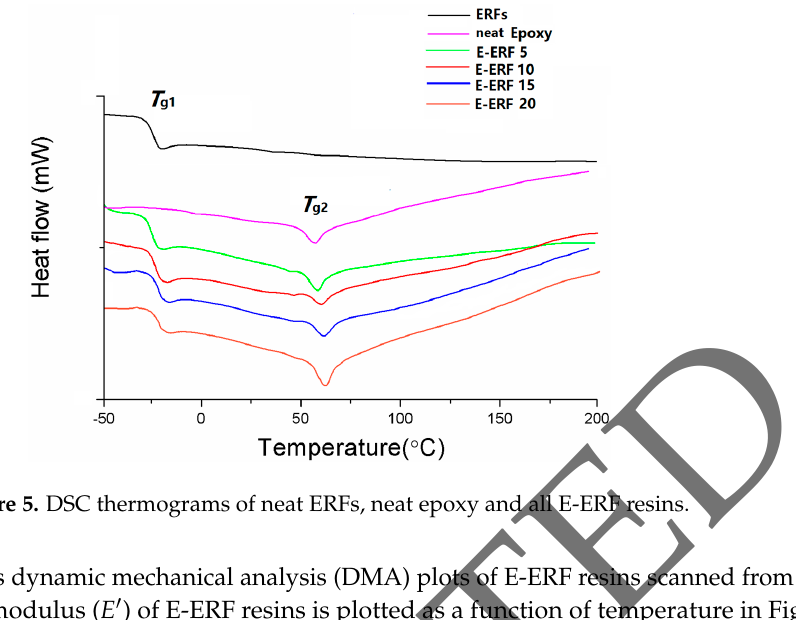
Figure 5. DSC thermograms of neat ERFs, neat epoxy and all E-ERF resins.